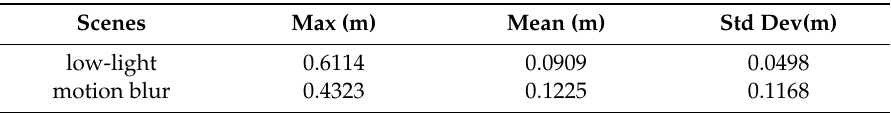
LiDAR data in low-light and motion blur